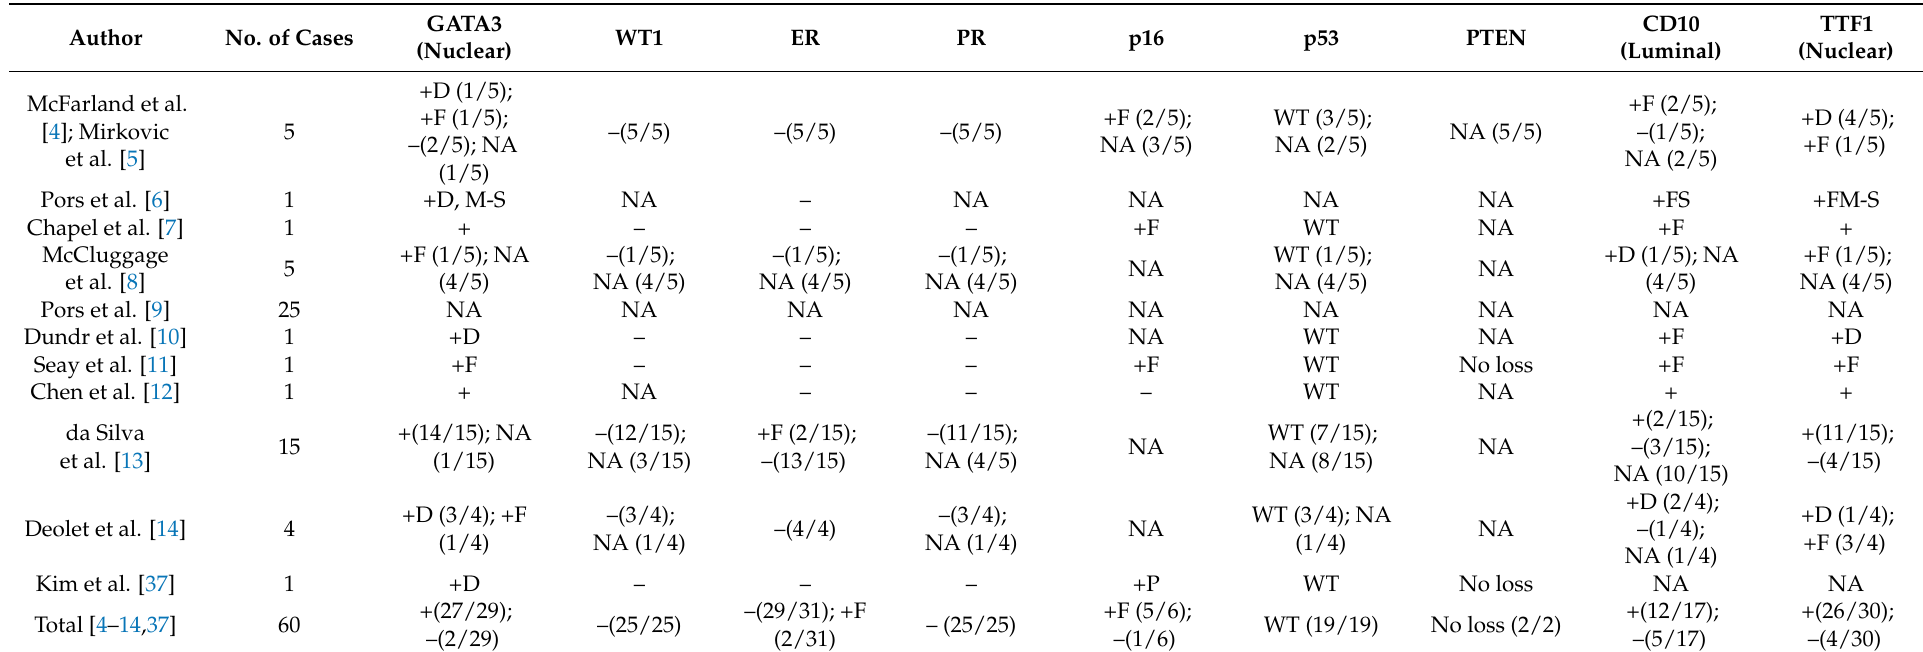
Table 6. Immunostaining results of previously published cases of ovarian mesonephric-like